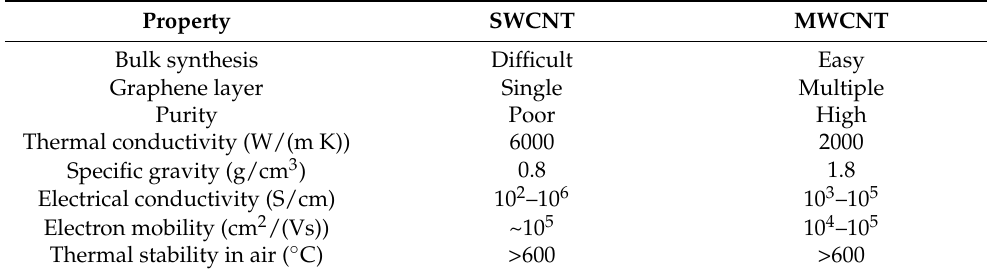
Table 1. Comparison between SWCNTs and MWCNTs